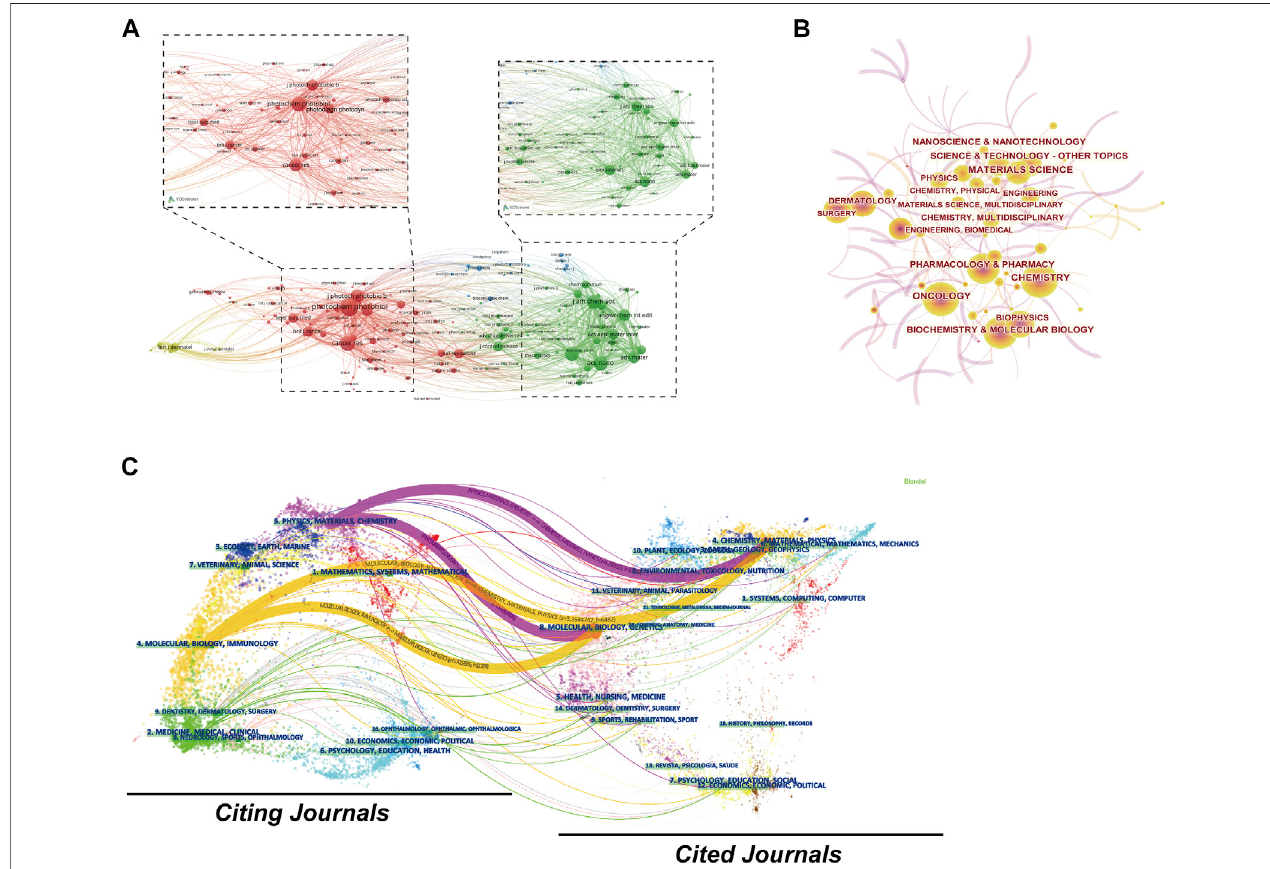
FIGURE 6 | (A) Journal co-citation analysis by VOSviewer. (B) Co-occurring subject categories network of CPDT by CiteSpace. (C) The dual-map overlay of journals related to CPDT. In the dual-map, the citing journals are located on the left, and the cited journal is on the right. Colored paths indicate the citation relationships, with the thicker lines representing main